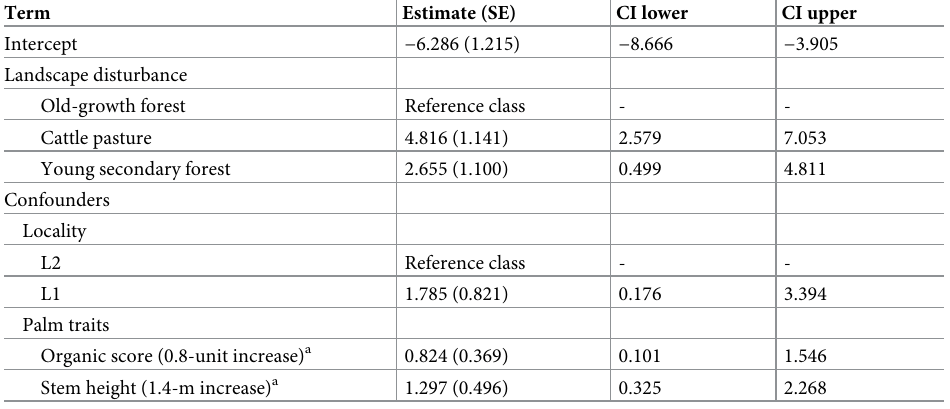
SE, standard error; CI lower and CI upper, lower and upper limits of the 95% confidence interval. a Variables standardized to mean 0.0 and standard deviation (SD) 1.0; effect estimates therefore correspond to an increase of 1 SD in the covariate value (indicated in